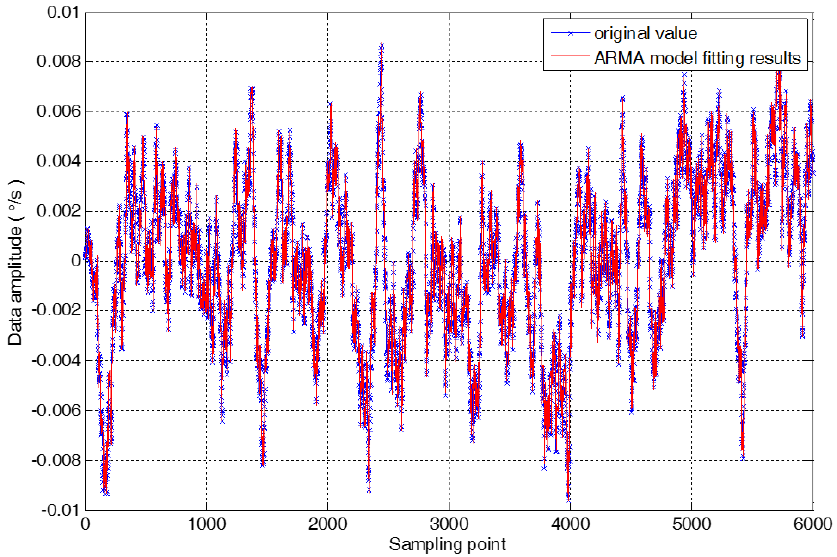
Figure 6. The original signal and the modeling result of the ARMA